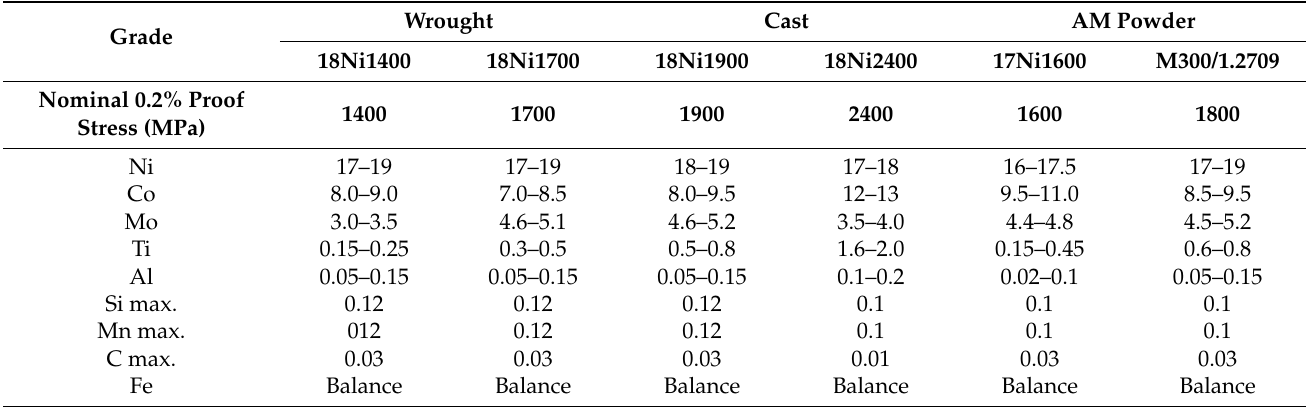
Table 1. Chemical composition of the most popular maraging steels [33–35].